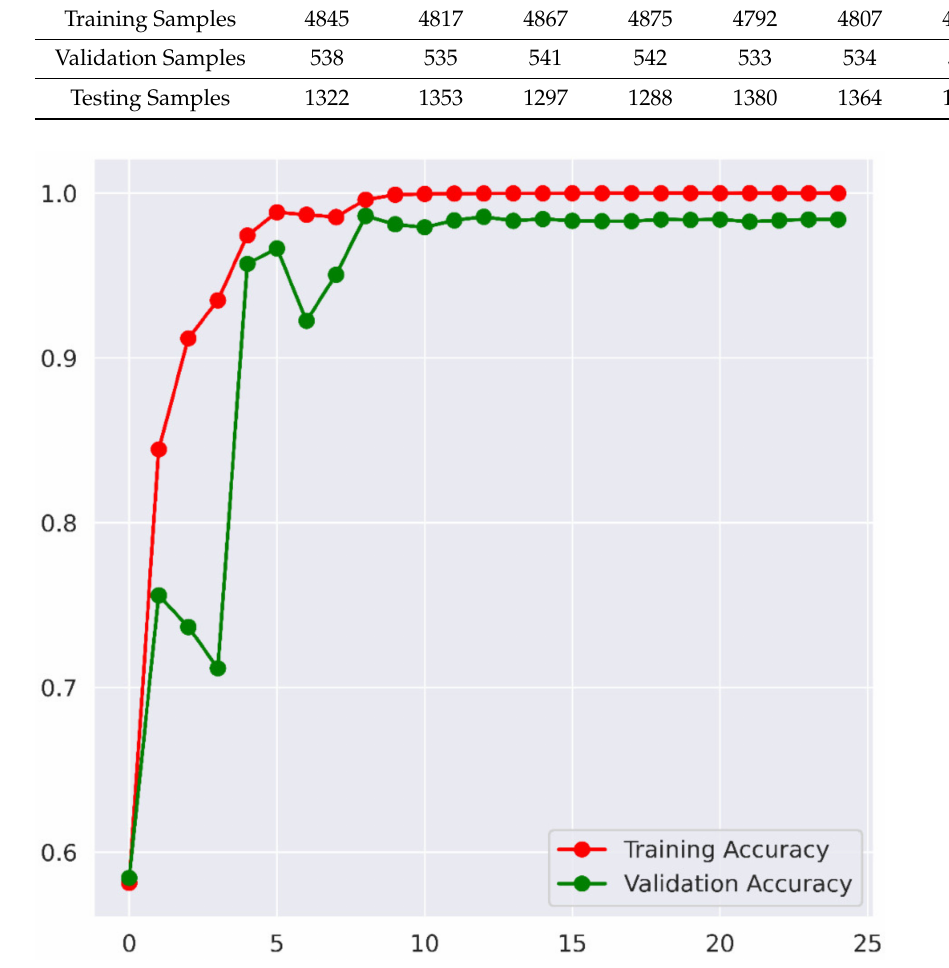
Figure 7. Accuracy graph for training and testing for